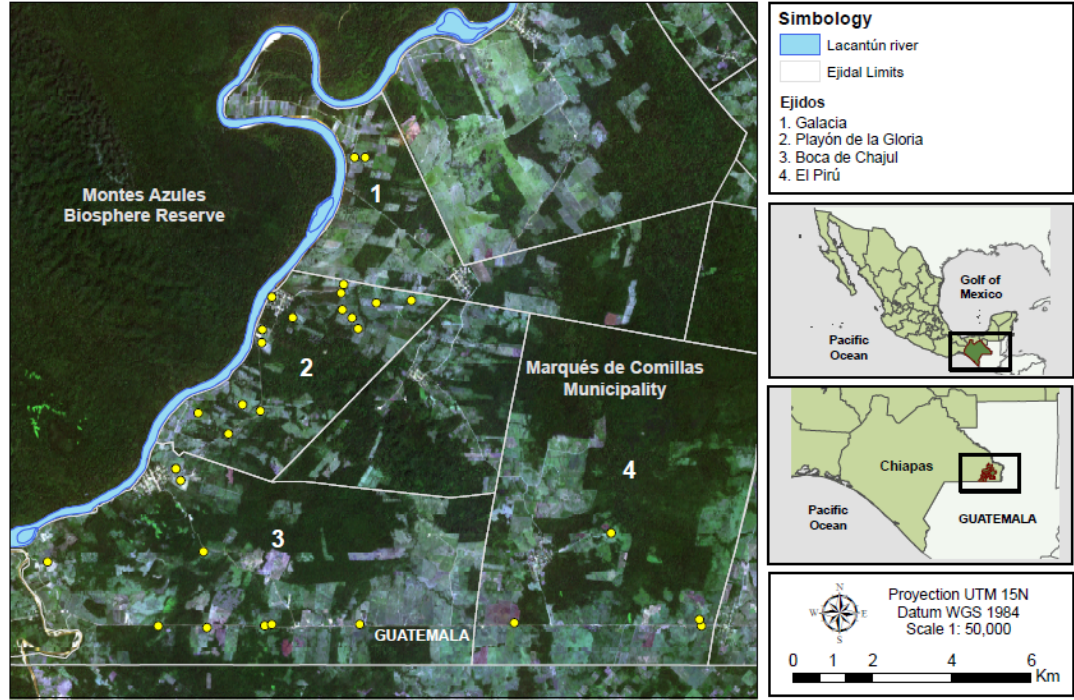
Figure 2. Location of the study plots. Montes Azules Biosphere Reserve on the left side of the Lacantún river and study plots located in the ejidos on the right side. The study was carried out in four ejidos (Boca de Chajul, Playón de la Gloria, Galacia and El Pirú) in Marqués de Comillas, Chiapas, México. Several vegetation types characterize the area, with rainforest still being the dominant one.